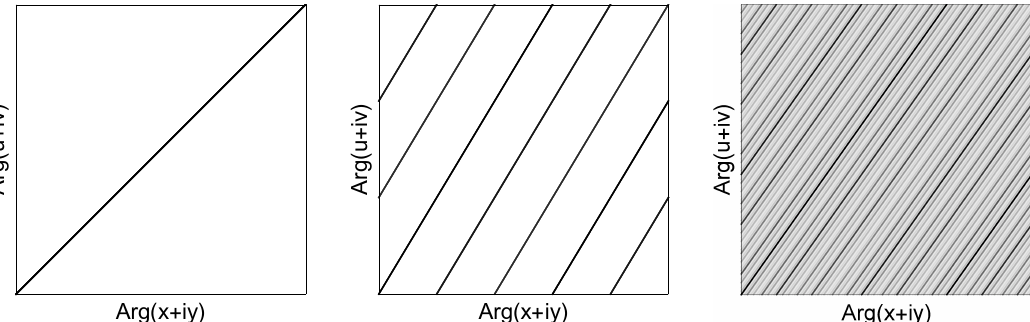
Figure 2: The motion (6) of a guiding center on a torus (at fixed x 2 + y 2 and u 2 + v 2 ), initially located in the square’s lower left corner. From left to right, the frequency (cid:112) ratio (7) takes values ∆ = 1, 5 / 3 and 2. The first and second cases ( ∆ = 1 or 5 / 3) are rational, producing periodic guiding center motion; ∆ = 1 is even isotropic. (cid:112) By contrast, the third case ( ∆ = 2) is not only anisotropic, but irrational. As a result, even a single guiding center trajectory covers the torus densely; the color- coding is such that the trajectory is initially black, then progressively fades to white. These pictures should be compared with their quantum counterparts, namely the edge correlations of figs.